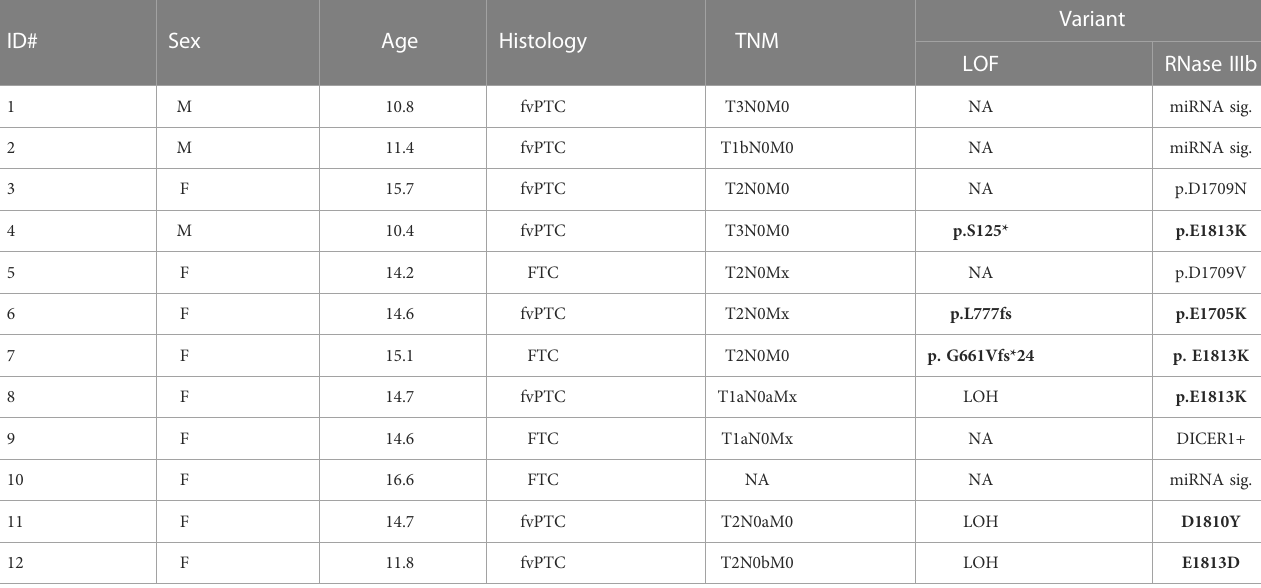
TABLE 1 Demographic and histopathological features of pediatric thyroid cancers with DICER1 RNase IIIb domain alterations.